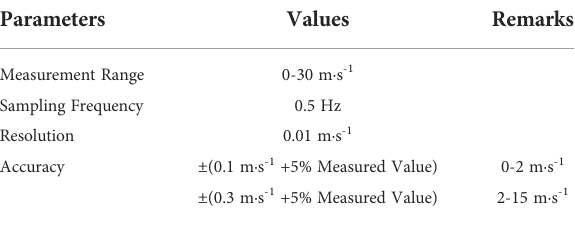
TABLE 2 The key speci fi cations of the thermal anemometer, Testo 405i. Parameters